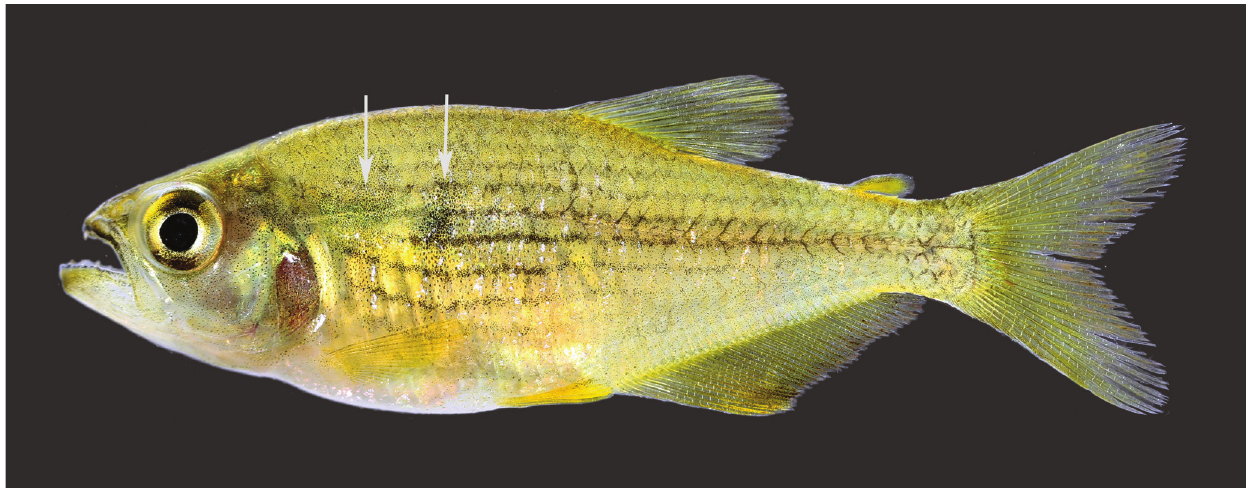
Fig. 4. Hollandichthys taramandahy , UFRGS 16513, paratype, 37.0 mm SL, lateral puddle of arroio Bananeiras, near the mouth of arroio da Barra, Itati, Rio Grande do Sul, Brasil. Live specimen. First (anterior) and second (posterior) humeral spots indicate with arrows.